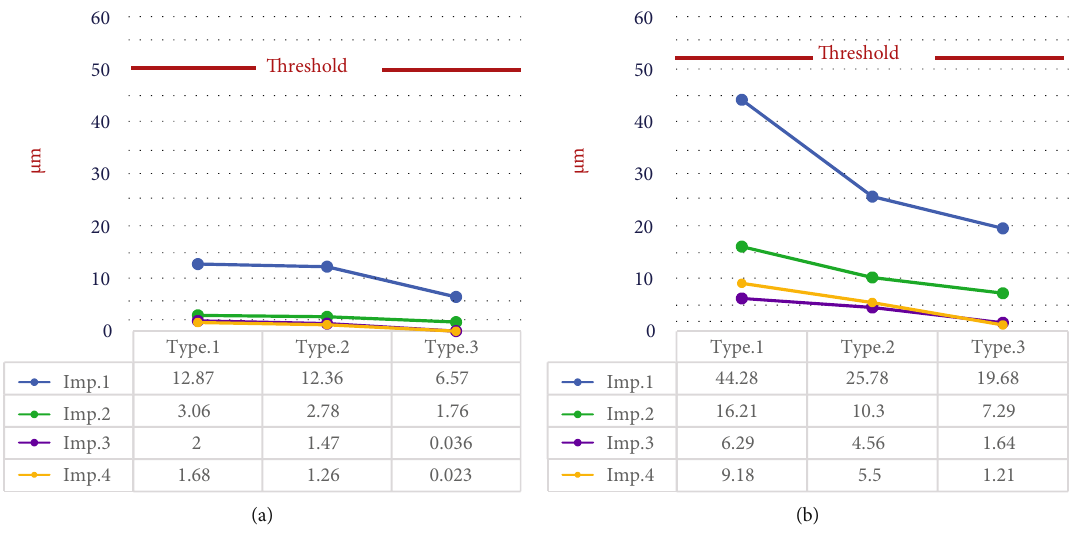
Figure 13: Displacement ( μ m) of the implants. (a) Normal-density model. (b) Low-density